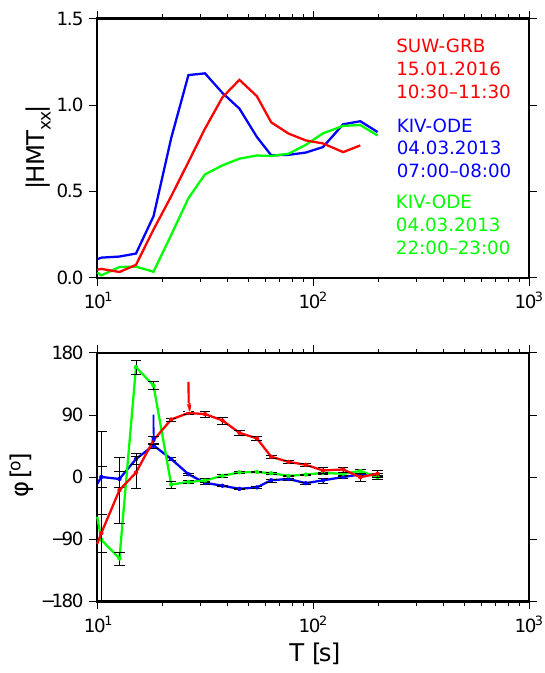
SUW and GRB (red) and KIV and ODE (blue) for 1h of data. Both show the typical pattern for field line resonances that allows for de- termination of the resonant frequency (indicated by arrows). It is 18s (55mHz) for the KIV-ODE pairing (midpoint latitude 44.5 ◦ ) and 26s (37mHz) for SUW-GRB (48.2 ◦ ). The green curve repre- senting KIV-ODE for another hour of data demonstrates that this transfer function is not stable in time, and such features may not re- liably appear because of a temporal lack of such resonances (almost zero absolute value below